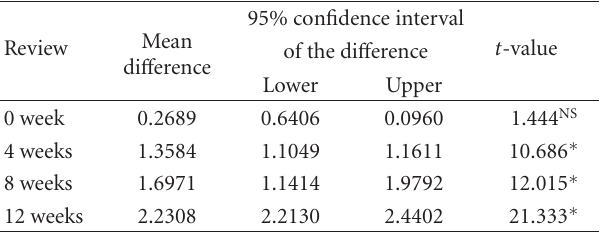
Table 4: Comparisons of WOMAC total mean score between group A and group